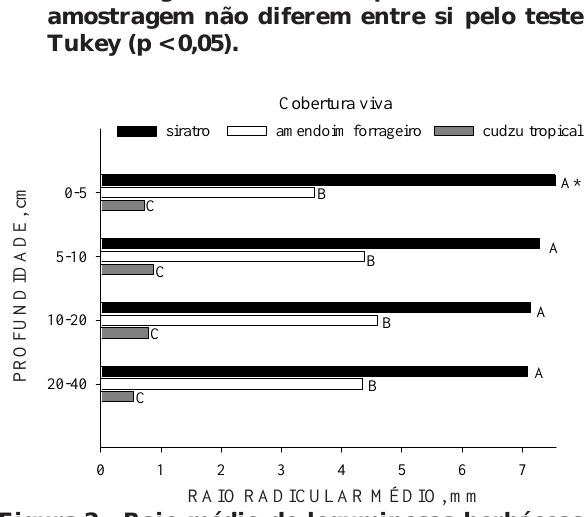
Figura 2. Raio médio de leguminosas herbáceas